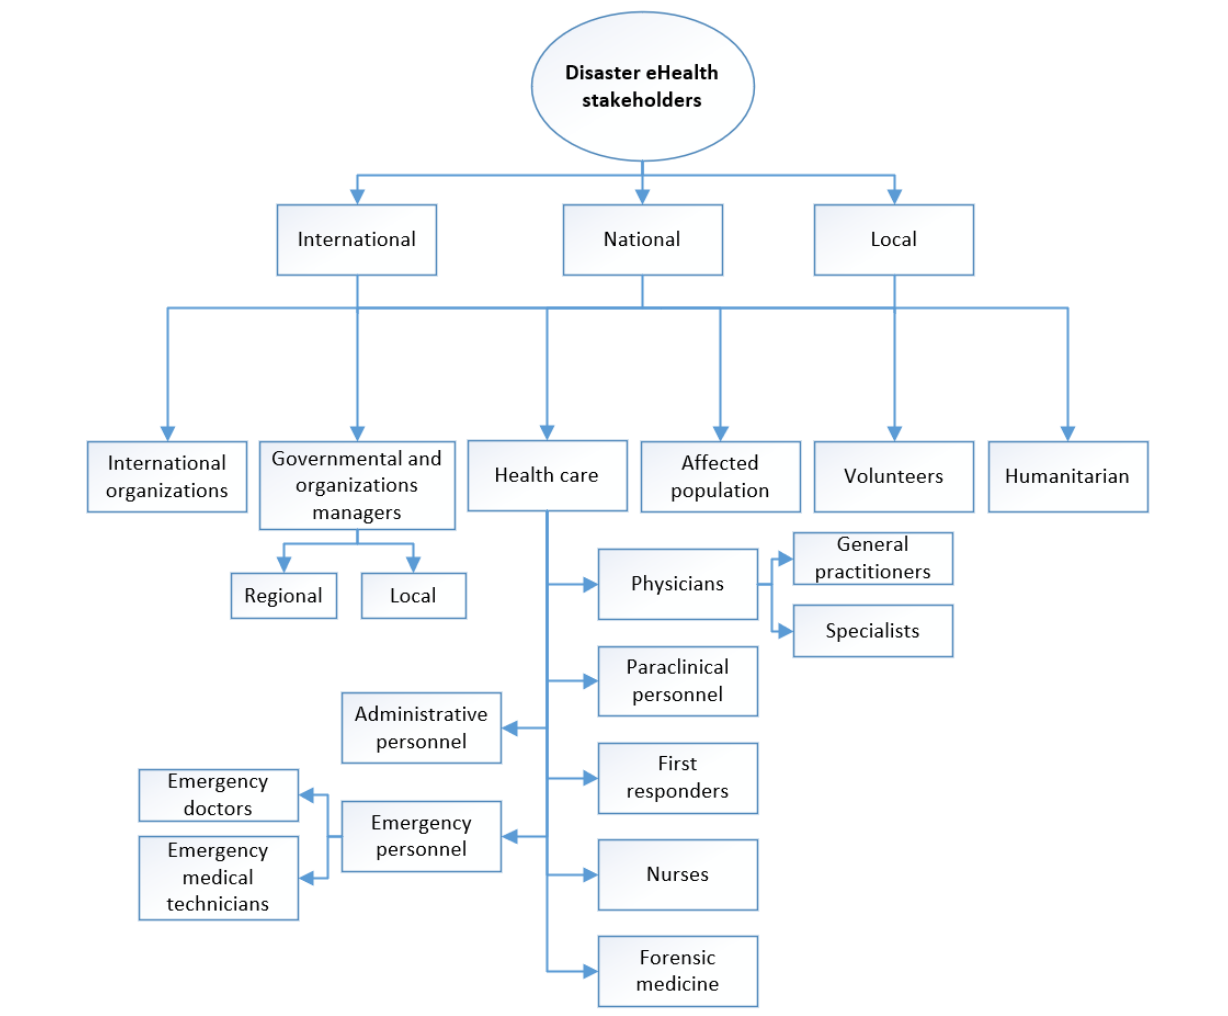
Figure 8. Disaster eHealth